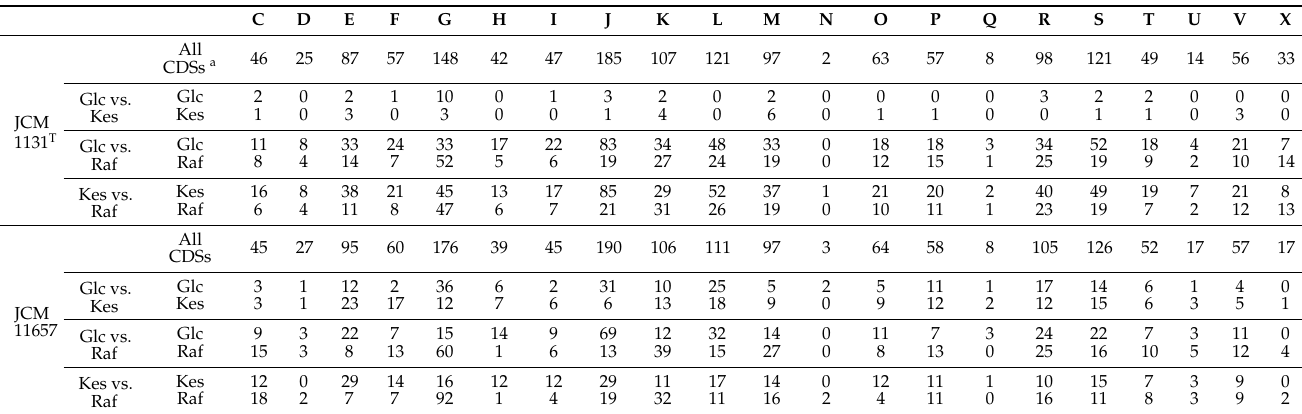
kestose, between glucose and raffinose, and between kestose and raffinose, respectively (Table 1). The differentially expressed genes were associated with 21 COG functional categories. Of the 69 differentially expressed genes between glucose and kestose in L. gasseri , 13 (accounting for 19% of the differentially expressed genes) were assigned to class G for carbohydrate transport and metabolism (Table 2). Class G again accounted for the largest proportion (approx. 10%) of the differentially expressed genes between glucose and kestose in L. paragasseri . Class J for translation, ribosomal structure, and biogenesis accounted for the largest proportion between glucose and raffinose and between kestose and raffinose in both strains, except that class G for carbohydrate transport and metabolism accounted for the largest proportion between kestose and raffinose in L. paragasseri . Table 1. Number of upregulated genes in the presence of different carbohydrates. Glc vs. Kes Glc vs. Raf Kes vs. Raf Glc ↑ a Kes ↑ Glc ↑ Raf ↑ Kes ↑ Raf ↑ JCM 1131 T